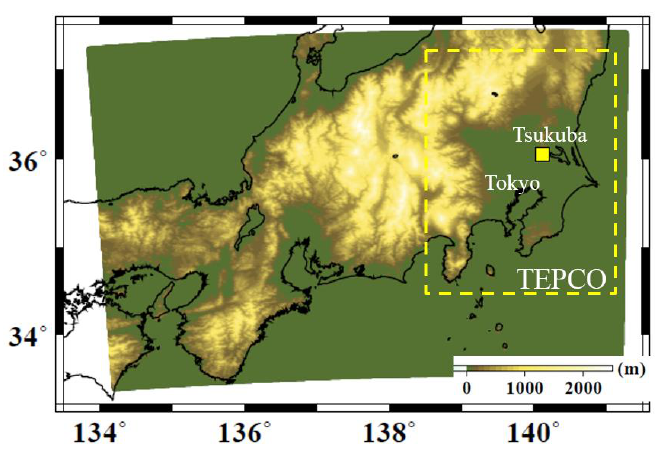
Figure 1. Topography of dx500m and the location of the Tsukuba station (yellow square). The yellow dashed rectangle indicates the Tokyo electric power company (TEPCO) area.